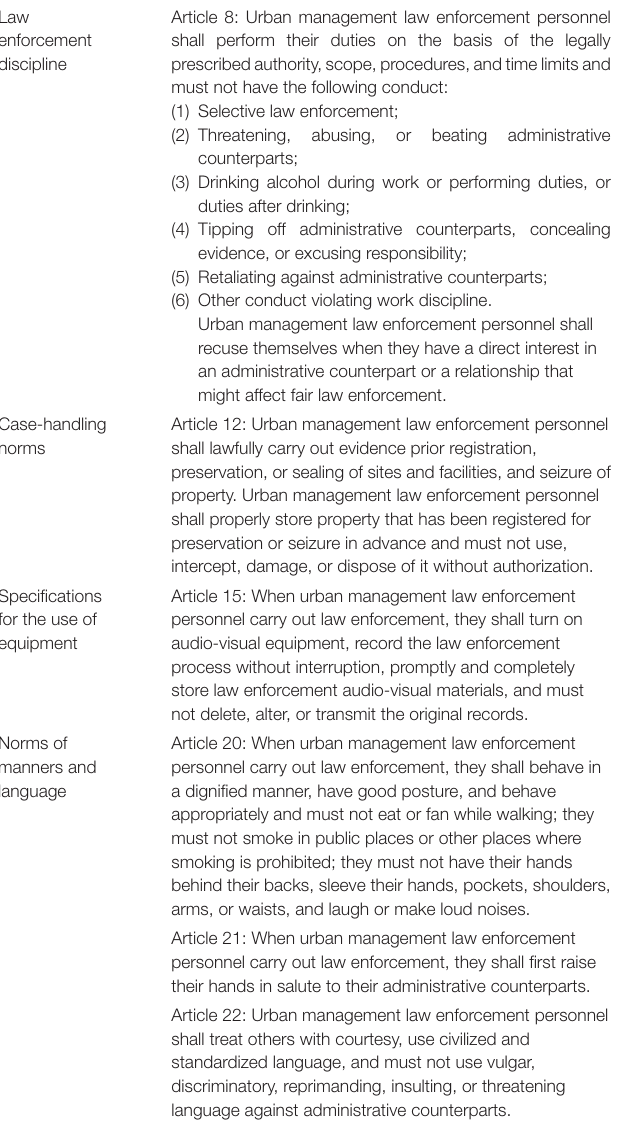
TABLE 1 | Metrics of Chengguan performance